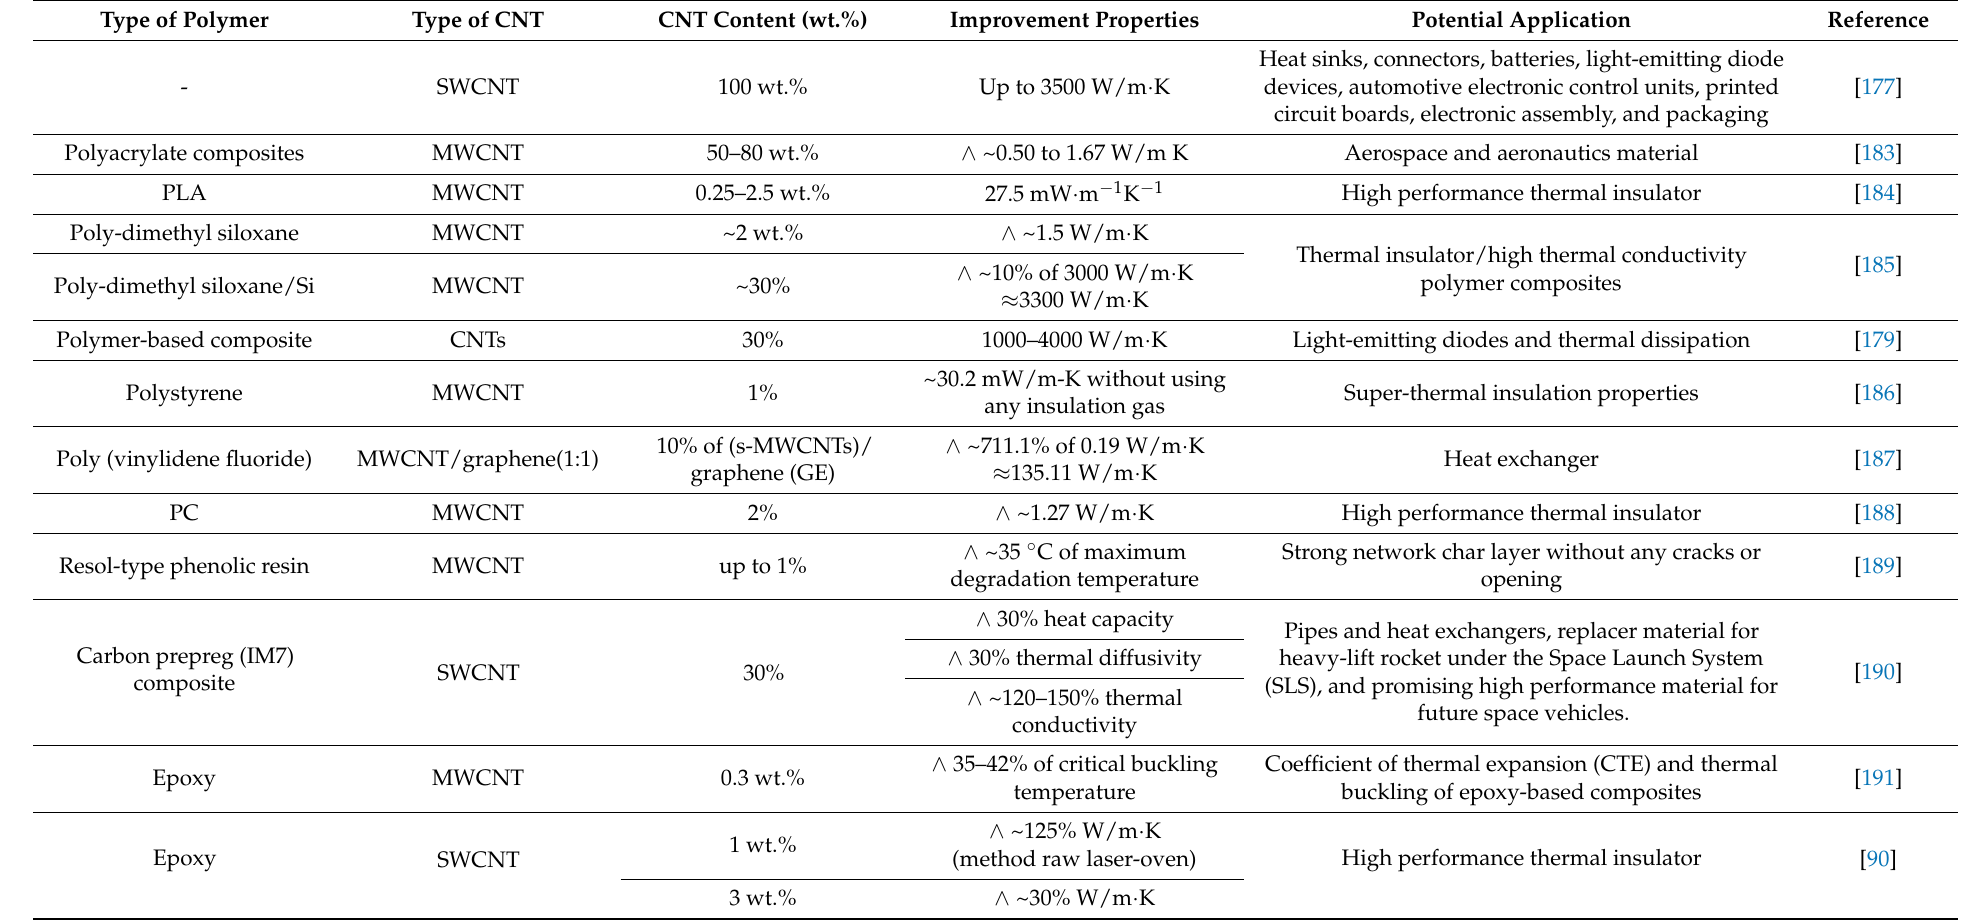
Table 8. Transmissions in the thermal properties of various CNT–polymer composite materials based on their